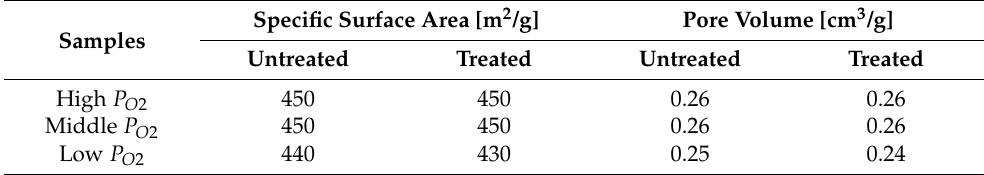
Table 3. Specific surface areas and pore volumes of untreated and vacuum-ultraviolet-treated films of woody carbon material estimated from CO 2 Brunauer-Emmett-Teller micropore